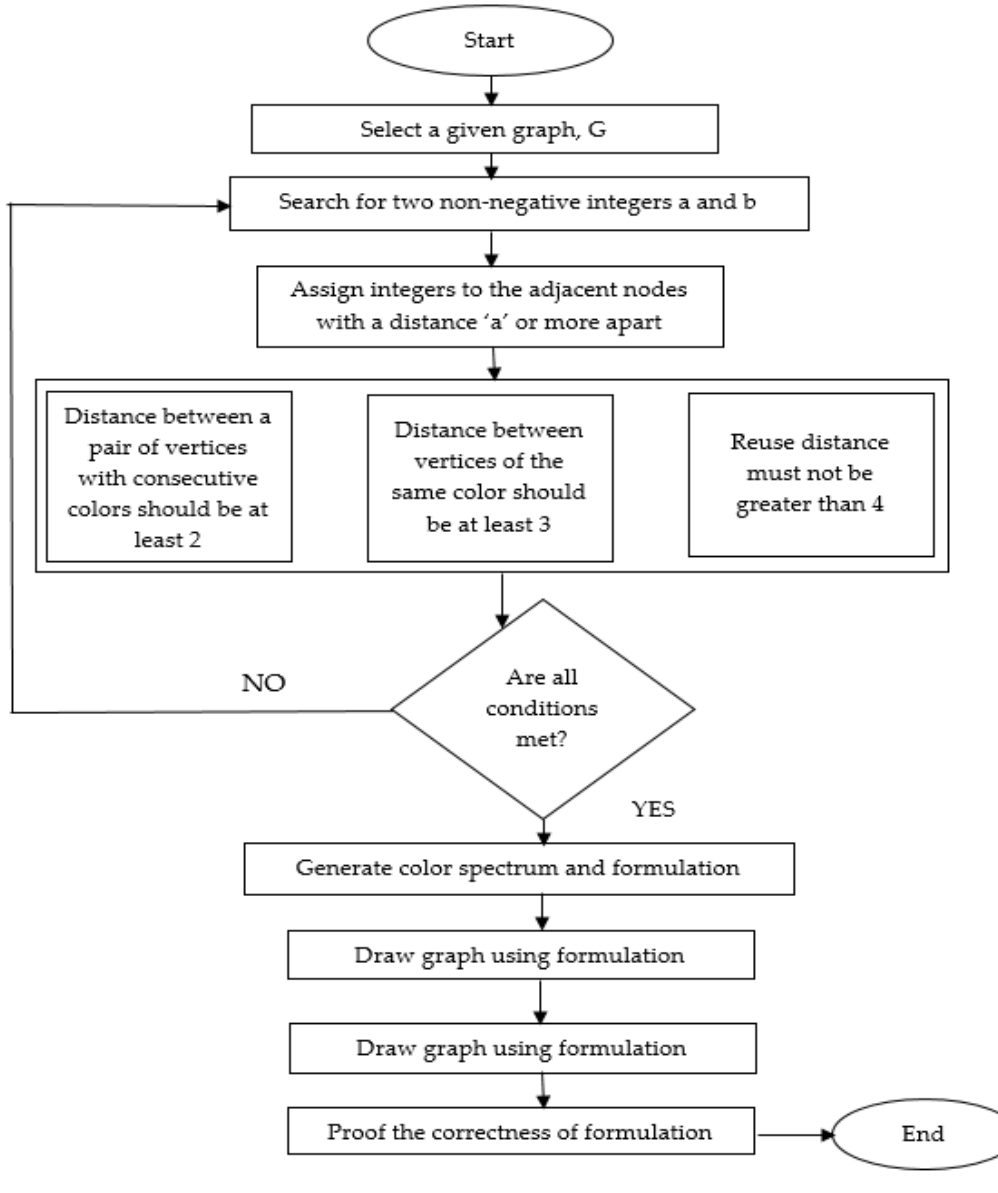
Figure 8. Flow chart for the formulation of the L(3,1) coloring algorithm.